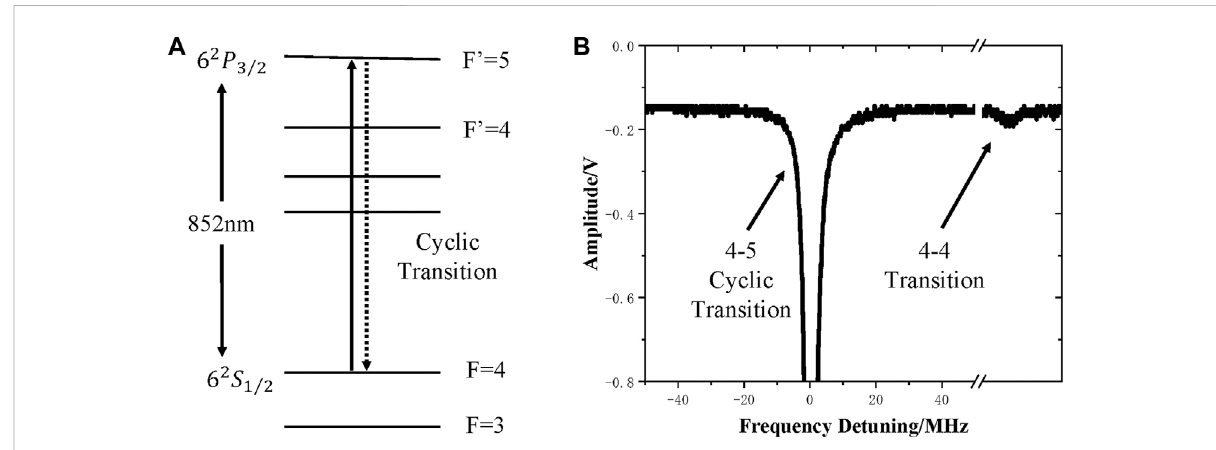
ratio. | F (cid:3) 4 〉 − | F ′ (cid:3) 5 〉 is a cyclic transition line of the D2 line